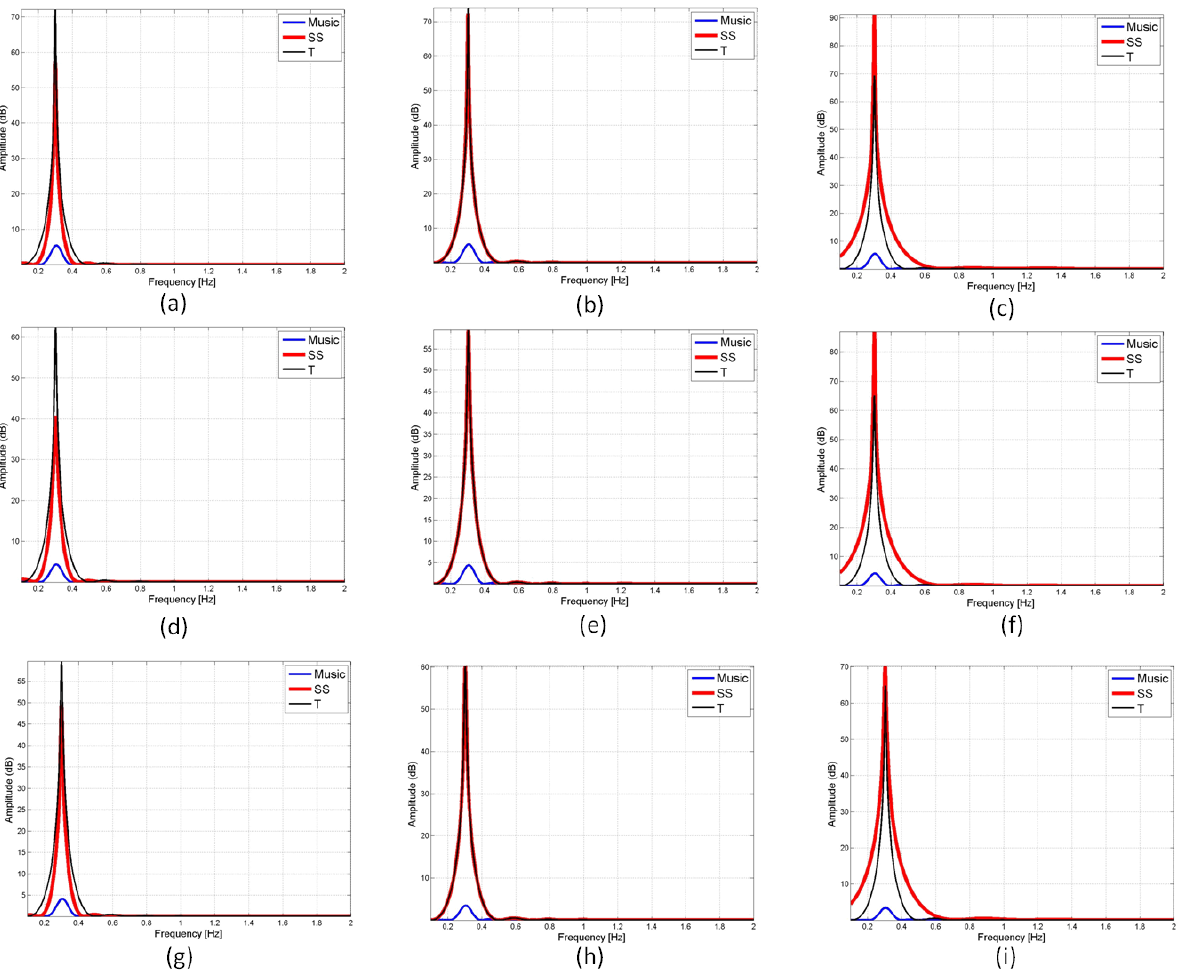
Figure 5: Synthetic data with L ∆ t = 10 s and L = 400 . Comparing SS (red line) and Toeplitz (black line) methods by varying the SNR level and the correlation index: (a) SNR = 20 dB , M d = 101 , (b) SNR = 20 dB , M d = L/ 2 , (c) SNR = 20 dB , M d = 301 , (d) SNR = 10 dB , M d = 101 , (e) SNR = 10 dB , M d = L/ 2 , (f) SNR = 10 dB , M d = 301 , (g) SNR = 5 dB , M d = 101 , (h) SNR = 5 dB , M d = L/ 2 , (i) SNR = 5 dB , M d =